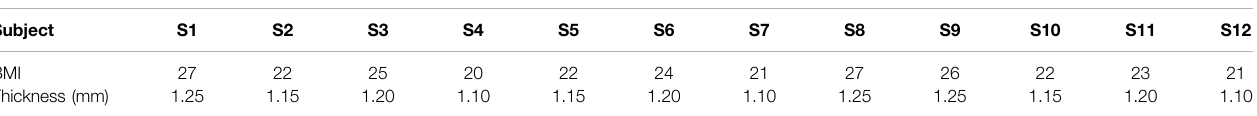
TABLE 1 | The calculated thickness for individual